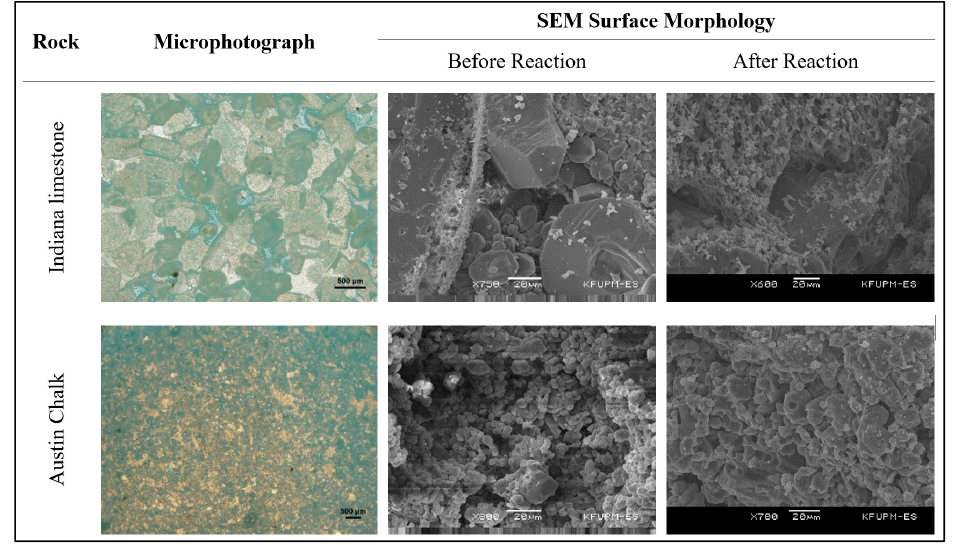
Figure 12. SEM and Microphotograph for a thin section of Indiana limestone and Austin chalk before and after reaction with GLDA/SW system at 200 °F and 1000 RPM.